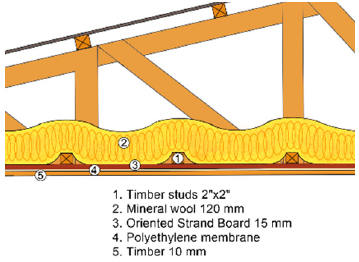
Figure 4. Ceiling cross-section, view in section. Own elaboration.